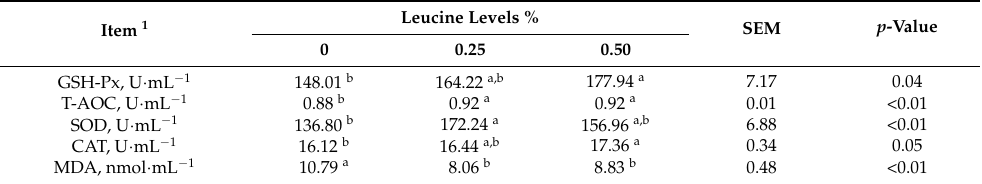
Table 9. Effects of different levels of leucine on Longissimus dorsal muscles antioxidant enzyme activities of finishing